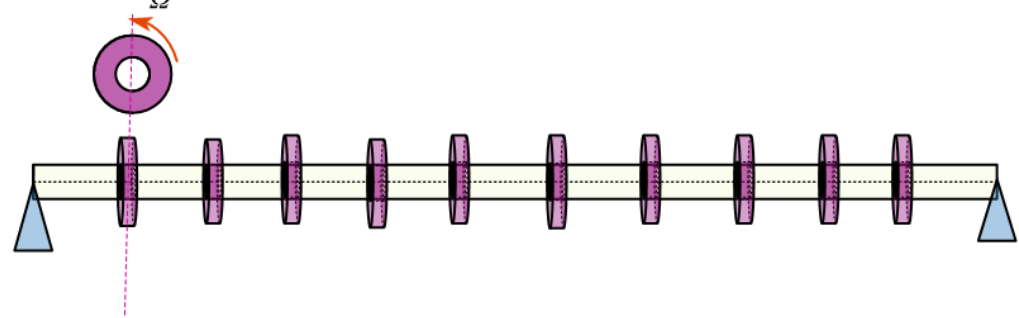
Figure 1. Diagram of an Euler beam with distributed gyroscopes.